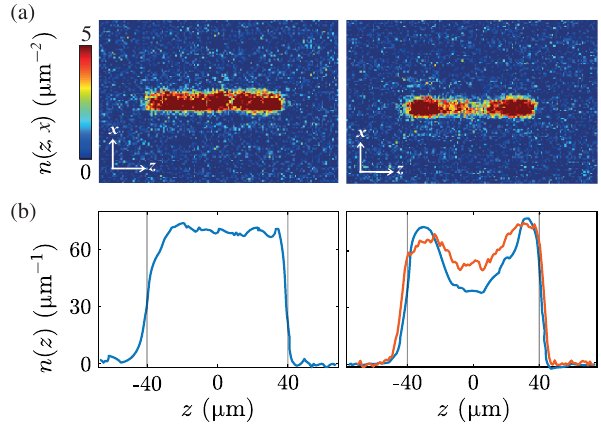
FIG. 7. (a) Absorption picture of the atomic cloud taken after 2 ms TOF. The box length is L ¼ 80 μ m. The image shows the atomic cloud trapped in a flat-box potential (on the left) and in a cosine potential (on the right). The short TOF produces an expansion of the cloud in the transverse direction, due to the strong 1D confinement, while its effect on the longitudinal dimension is negligible. (b) Averaged longitudinal density profile for the cloud trapped in a flat-box potential (on the left) and in a cosine potential (on the right). The two density profiles on the right side correspond to two different amplitudes.